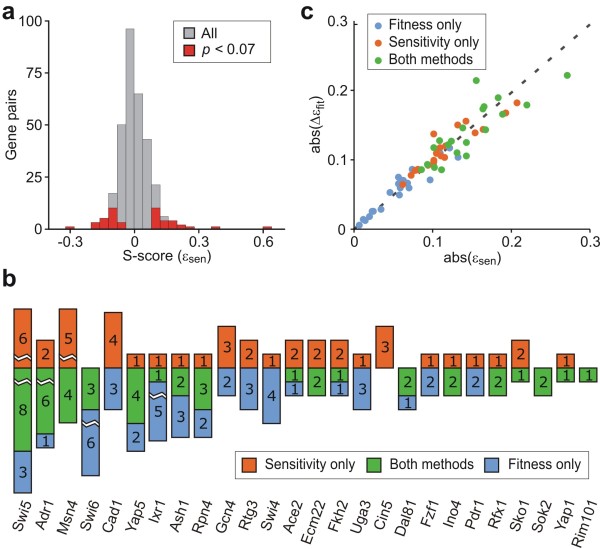
Comparison of fitness- and sensitivity-based epistatic analysis. (a) Histograms of sensitivity-based epistasis scores (S-Score) for all TF pairs (grey) and the 45 most likely epistatic interactions (red). (b) The number of epistatic interactions identified for each TF categorized according to the methodology by which the interaction was identified. (c) Correlation between the absolute S-score and the absolute difference in F-scores in the presence and absence of MMS.